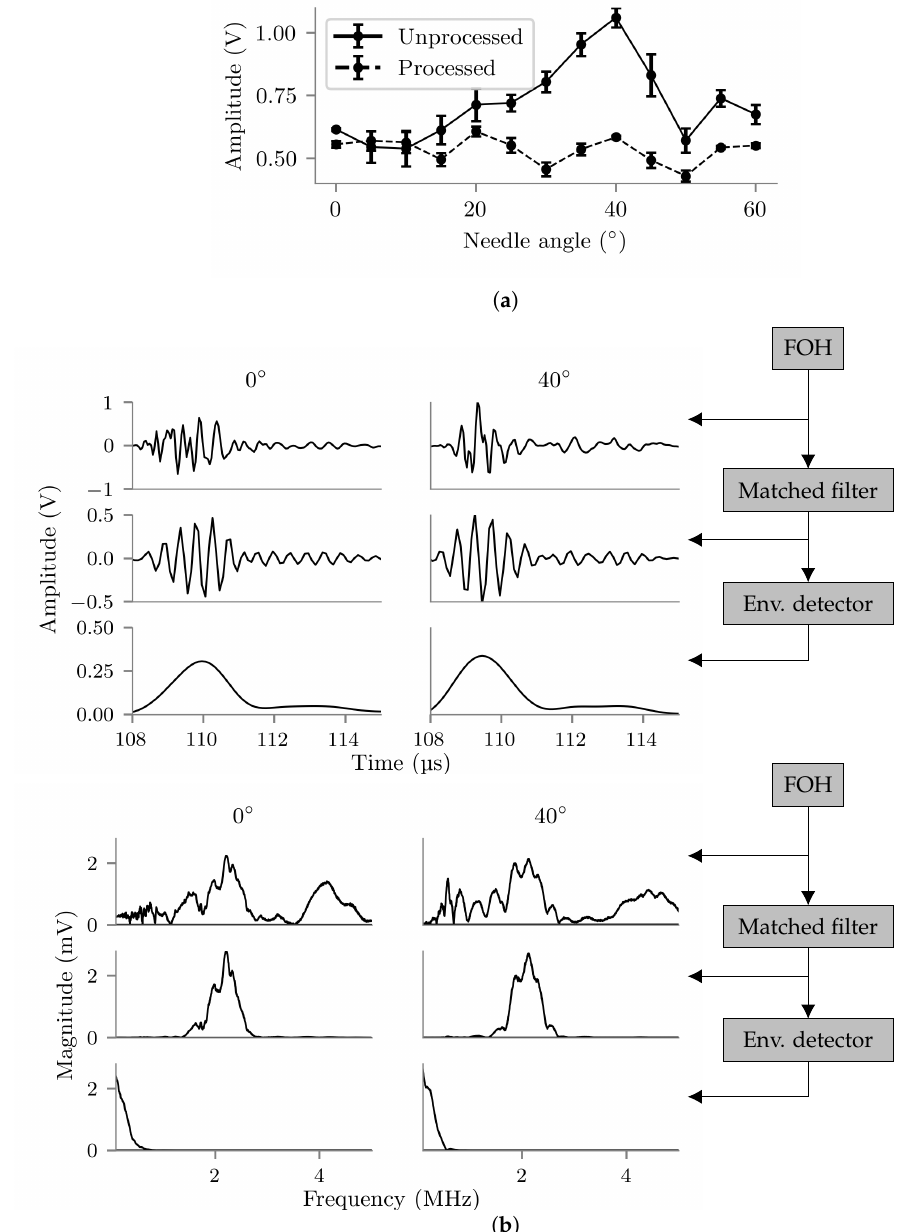
Figure 11. ( a ) Voltage amplitudes of unprocessed and processed FOH waveforms acquired with the needle at thirteen different insertion angles. Error bars show the standard deviation across three true-repeat measurements. ( b ) FOH waveforms ( top figure) and frequency spectra ( bottom figure) before processing ( top rows), after matched filtering ( middle rows) and after full processing ( bottom rows) acquired with needle insertion angles of 0 ◦ ( left column) and 40 ◦ ( right column). Measurements were made with the needle tip located on the central vertical axis of the US image, approximately 150mm from the imaging probe